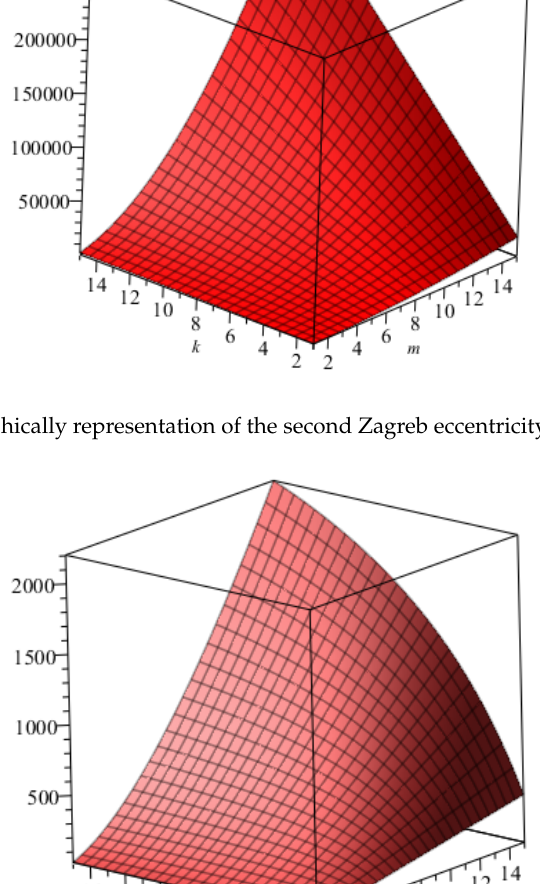
Figure 6. The graphically representation of the third Zagreb eccentricity index M ∗∗